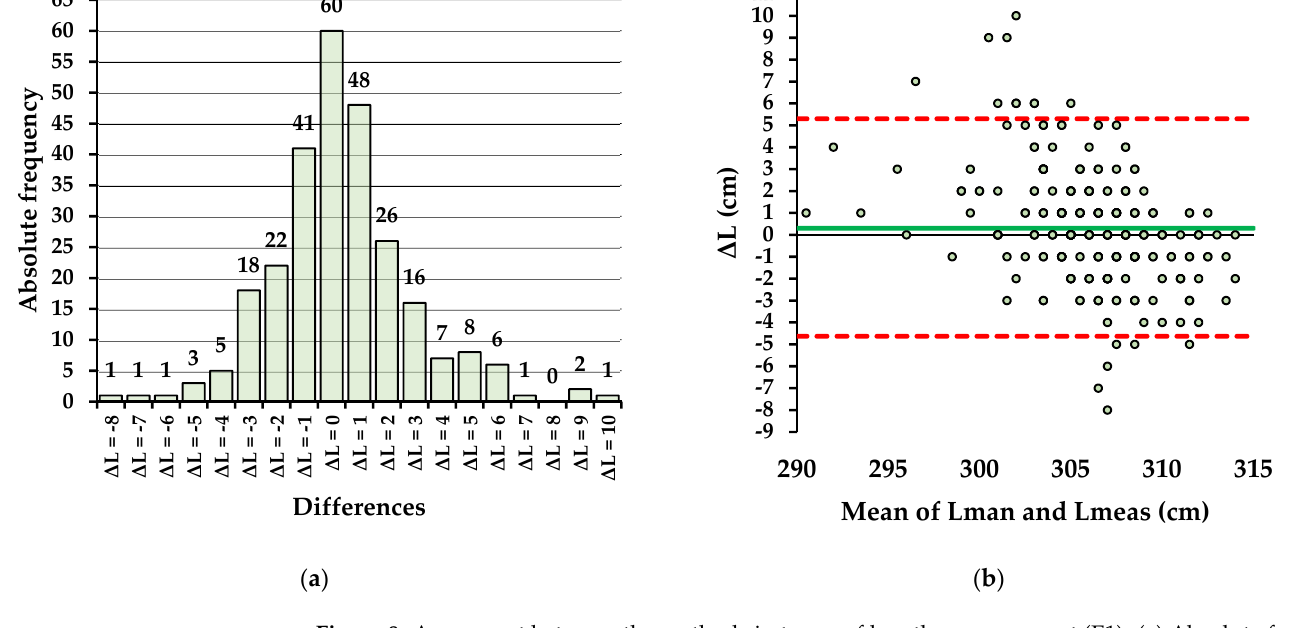
Figure 8. Agreement between the methods in terms of length measurement (E1): ( a ) Absolute fre- quency of differences ( Δ L) between Lman and Lmeas; ( b ) Bland-Altman plot showing the differences plotted against the mean of paired measurements, the bias (green line), and the lower and upper limits of agreement (red dashed lines).